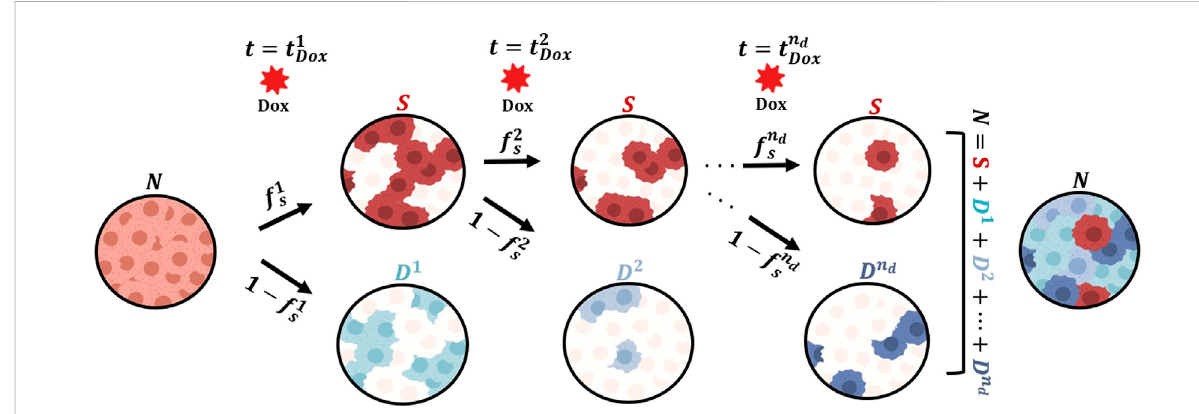
FIGURE 1 Generalized model of tumor cell response to multiple doses of doxorubicin treatment. We start with a population of untreated tumor cells and let them grow for approximately 48 h. At time t 1 Dox , we add a dose of doxorubicin (Dox) to each well. We assume that after the treatment, the tumor cells either survive ( S ) or are irreversibly damaged ( D 1 ) and ultimately die due to the cytotoxic action of doxorubicin. The fraction of cells in either subpopulation is determined by f 1 s , the fraction of surviving cells after the fi rst dose. After the subsequent n d doses of doxorubicin ( i (cid:1) 2 , 3 , ... , n d ), we assume that a fraction f i s of the surviving cells survive the treatment, while a fraction ( 1 − f i s ) induces a new subpopulation of irreversibly damaged cells ( D i ) , such that the total number of tumor cells is N (cid:1) S + D 1 + D 2 + ... + D n d for times t > t n d Dox . In this study, we further assess whether the collection of f